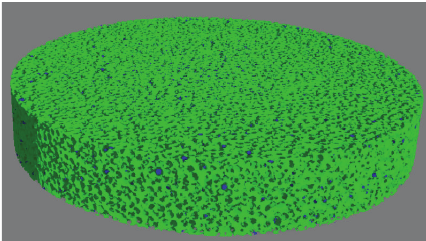
Figure 2: Microtomography. 3D image reconstruction of the pore volume of the specimen “Large” after measurement with X-ray microtomography. The dark areas represent the powder spheres while the pore volume is shown in green.